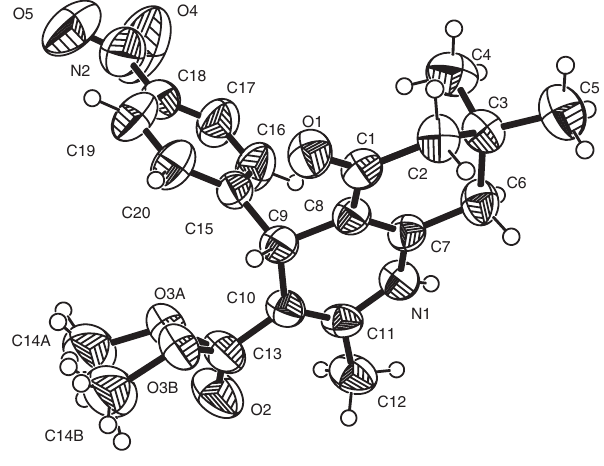
Table 1: Data collection and handling.